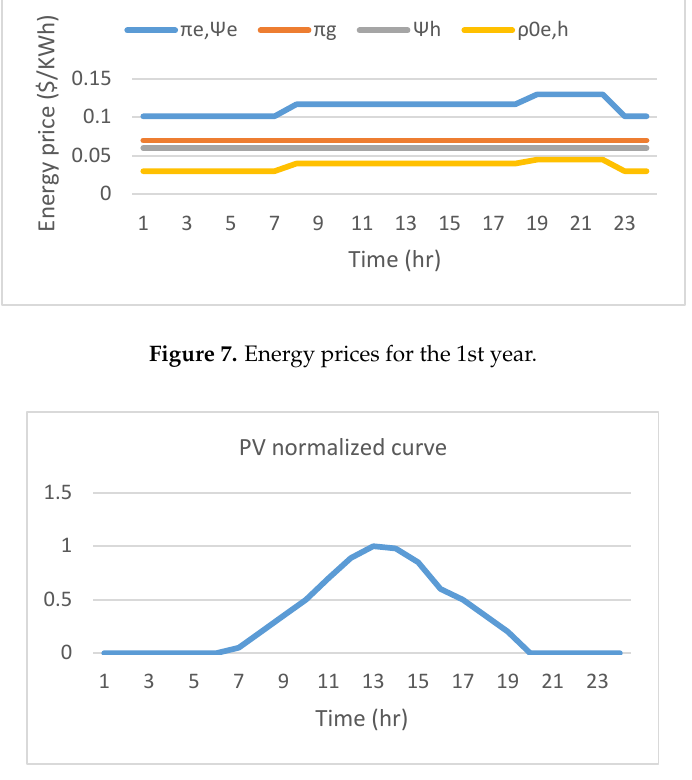
Figure 8. The normalized PV generation curve on a summer day.